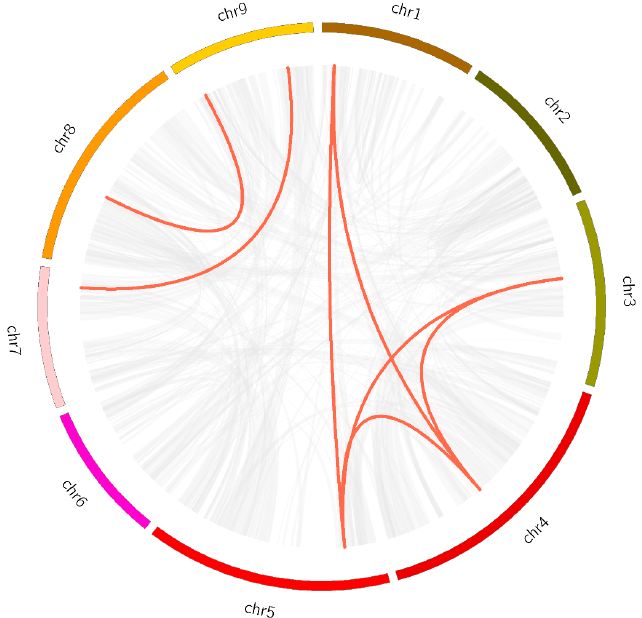
Figure 5. Synteny analysis of LsMAPK genes in lettuce. Colored circular rectangles represent the chromosomes (1–9) of lettuce. Grey and red curves represent the identified collinear blocks with the genomes and the collinear with LsMAPK genes, respectively.